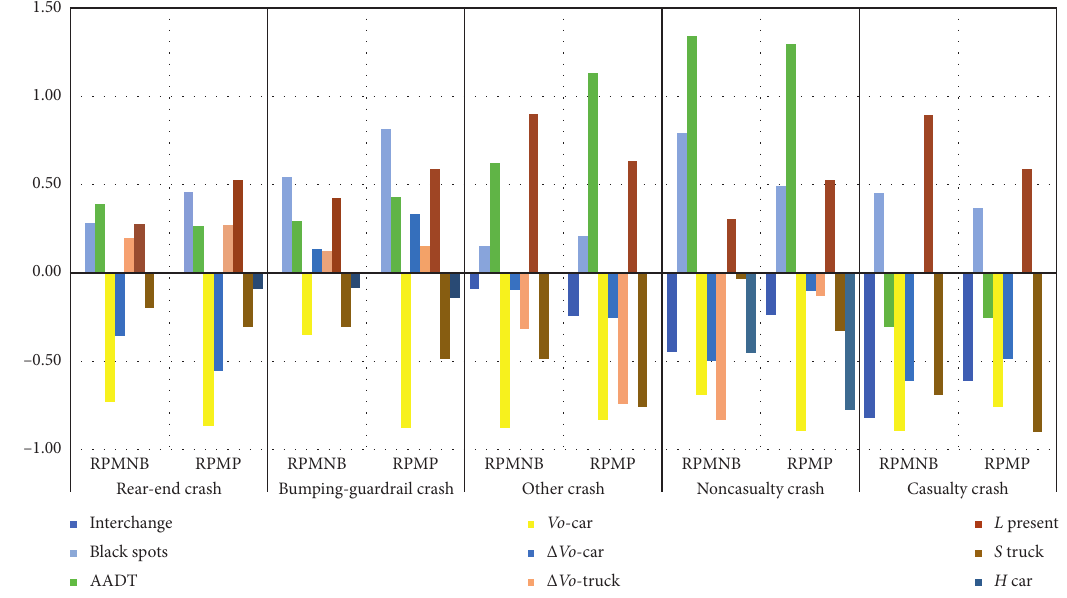
Figure 1: Elasticity effects across two models (RPMNB and RPMP) for 5 crash types.